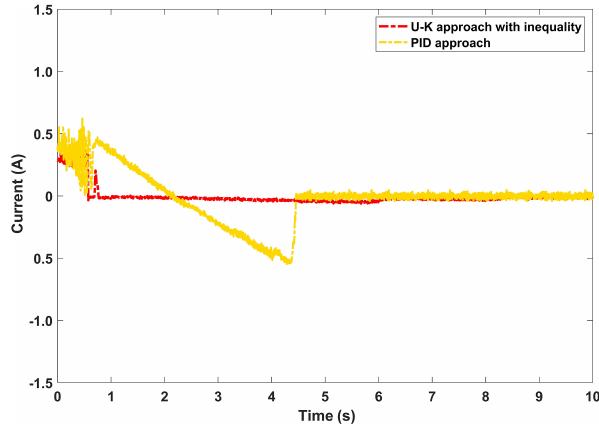
Figure 10. The experimental results of the transient performance of U–K with the inequality constraint and PID.